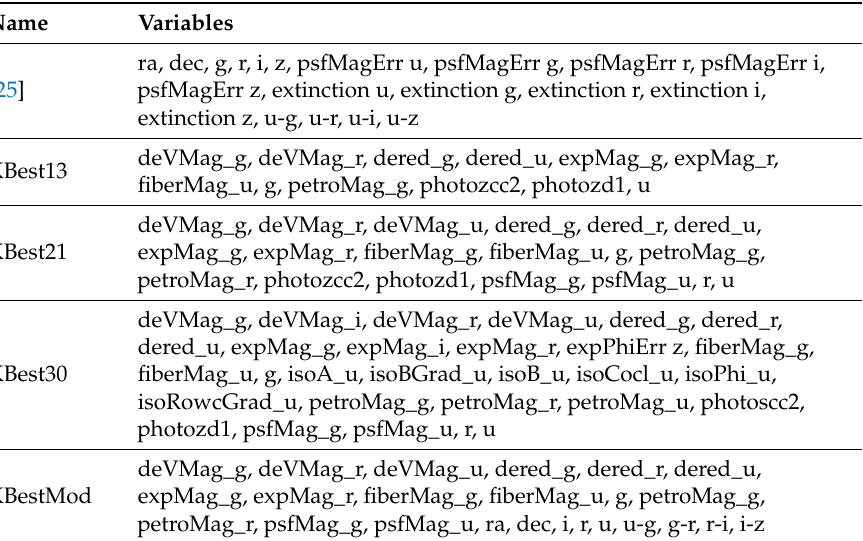
Table 1. Variable